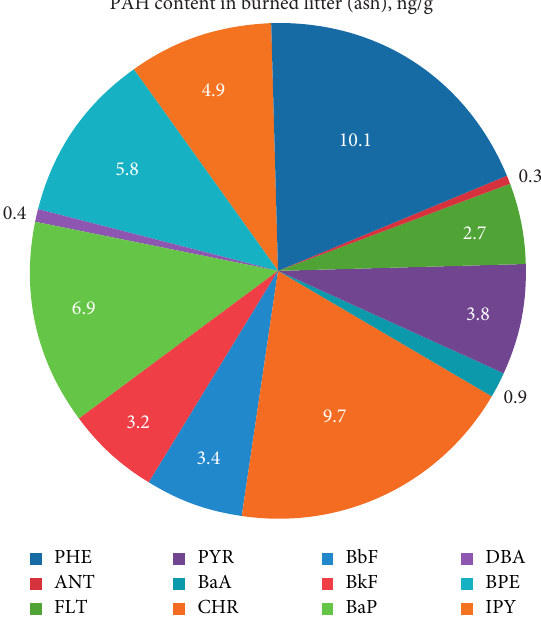
Figure 9: PAH component composition in fire-affected